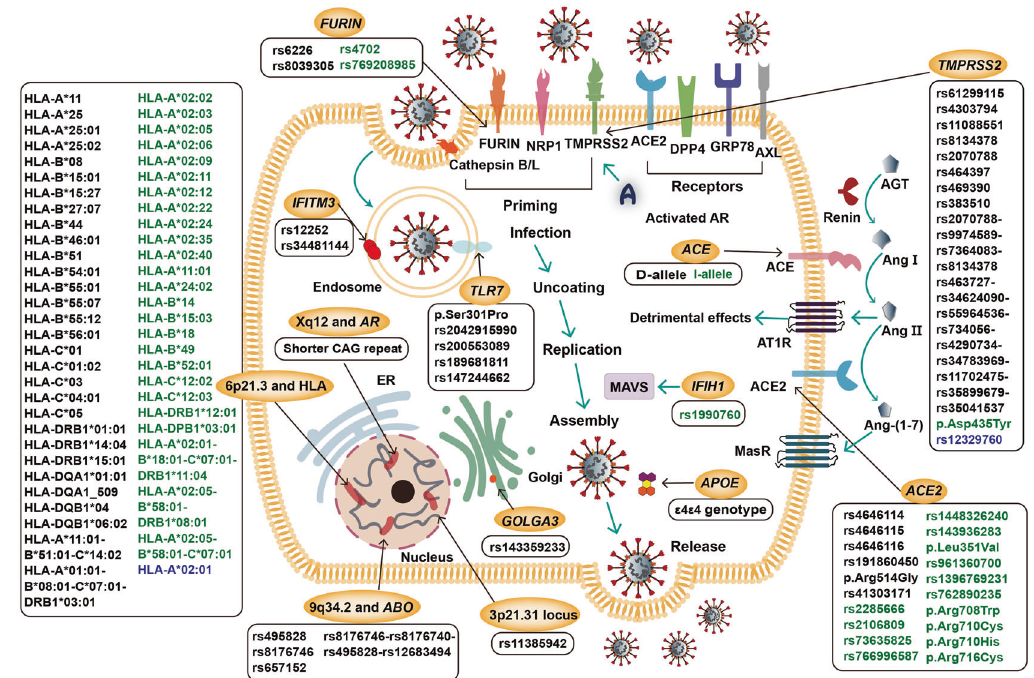
Fig. 1 Pathogenesis of SARS-CoV-2 and genetic variants associated with COVID-19. After the recognition of ACE2, DPP4, GRP78, and AXL receptors and the priming by TMPRSS2, FURIN, and NRP1, as well as cathepsin B/L, SARS-CoV-2 enters cells and starts the replication process to assemble and release. Activated AR induces TMPRSS2 expression. ACE/Ang II/AT1R and ACE2/Ang-(1 – 7)/MasR axes regulate RAAS to involve in COVID-19. The risk (black), protective (green), and uncertain (blue) variants or alleles or haplotypes for COVID-19 are highlighted. SARS-CoV- 2 severe acute respiratory syndrome coronavirus 2, COVID-19 coronavirus disease 2019, ACE2 angiotensin-converting enzyme 2, DPP4 dipeptidyl peptidase 4, GRP78 glucose-regulated protein-78, AXL anexelekto, TMPRSS2 transmembrane protease serine 2, FURIN furin, paired basic amino acid-cleaving enzyme, NRP1 neuropilin-1, AR androgen receptor, AGT angiotensinogen, Ang angiotensin, ACE angiotensin- converting enzyme, AT1R angiotensin II type 1 receptor, MasR Mas receptor, TLR7 the Toll-like receptor 7 gene, IFITM3 the interferon induced transmembrane protein 3 gene, HLA human leukocyte antigen, GOLGA3 the golgin A3 gene, ABO the ABO, alpha 1 – 3- N - acetylgalactosaminyltransferase and alpha 1 – 3-galactosyltransferase gene, APOE the apolipoprotein E gene, IFIH1 the interferon induced with helicase C domain 1 gene, MAVS mitochondrial antiviral signaling protein, ER endoplasmic